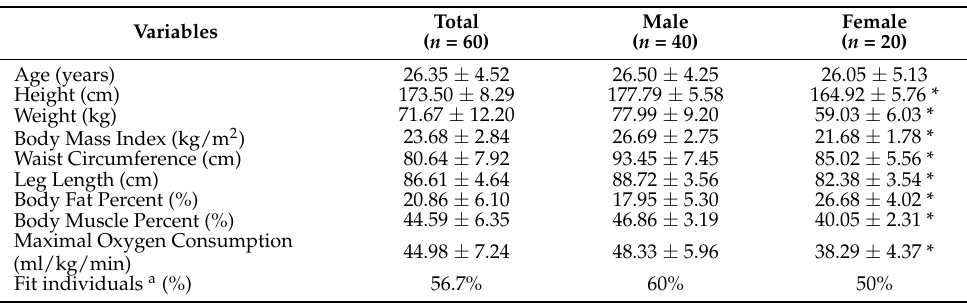
Table 1. Participants’ physical